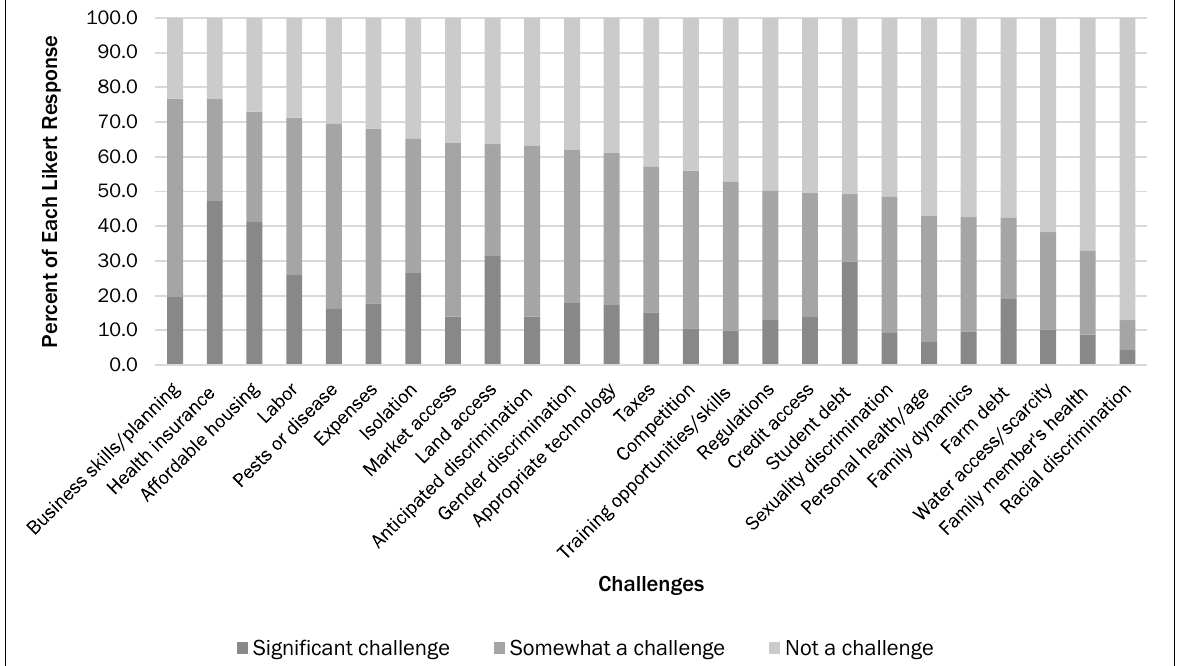
Figure 1. Challenges Reported by Queer